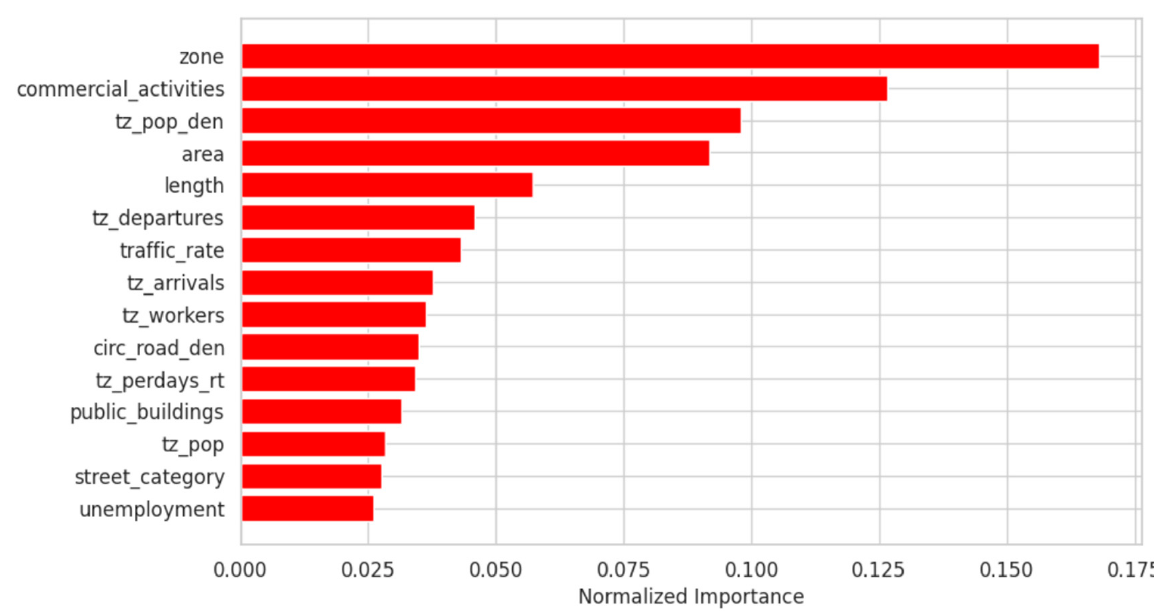
Figure 12. Ranked feature importance within the dataset.